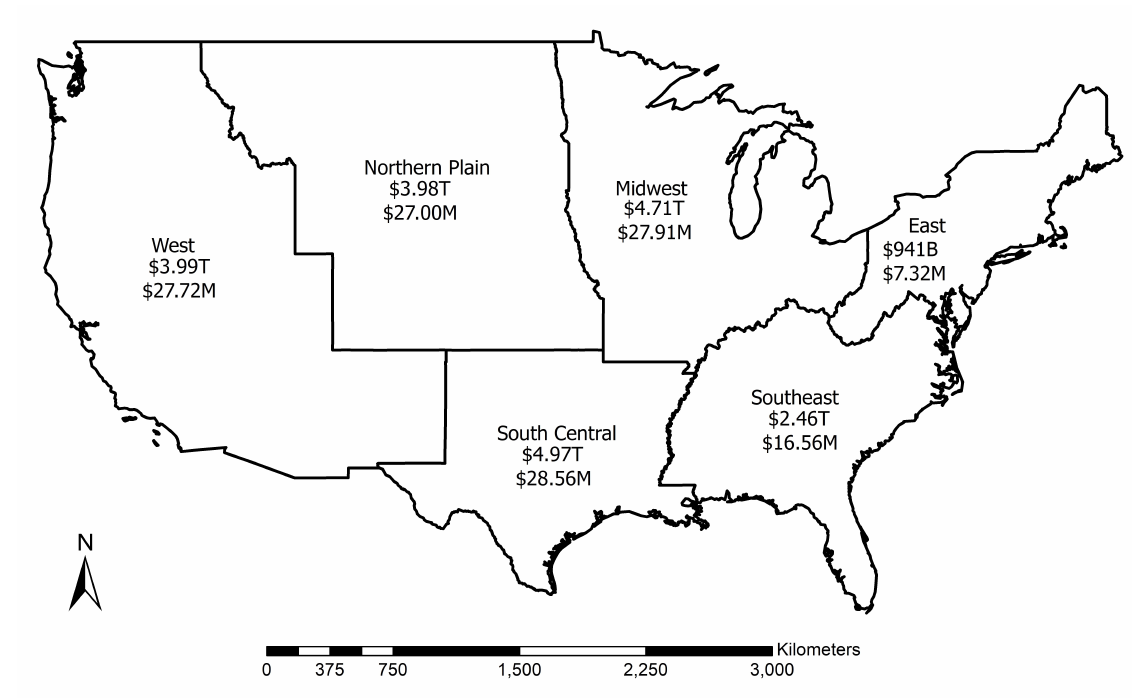
Figure 4. Total soil carbon (intrinsic, top number ) and average annual total (extrinsic, bottom number) monetary values of non-constrained potential soil inorganic carbon (SIC) sequestration from combined atmospheric Ca 2+ and Mg 2+ deposition (2000–2015) for different regions in the contiguous United States (U.S.) based on an avoided SC–CO 2 of $42 per metric ton of CO 2 [51] (adapted from Mikhailova et al., 2019 [36]; Mikhailova et al., 2020 [52]). Note: M = million = 10 6 , B = billion = 10 9 , and T = trillion = 10 12